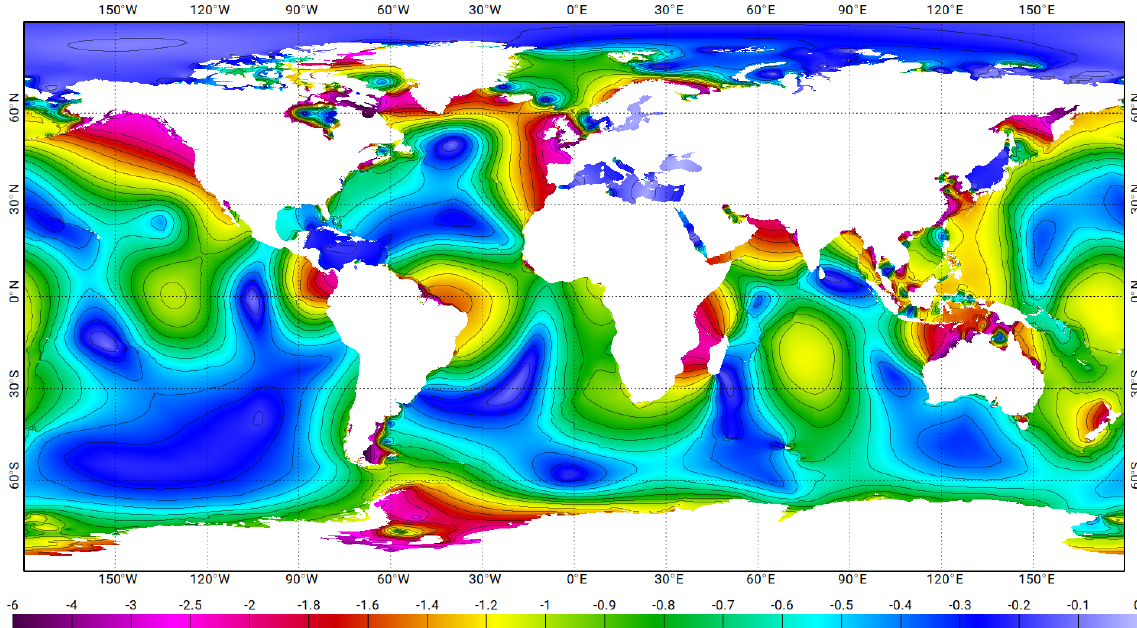
Figure 23. Lowest astronomical tides (LATs) relative to mean sea level computed from a 20-year FES2014b tidal prediction. Units are in